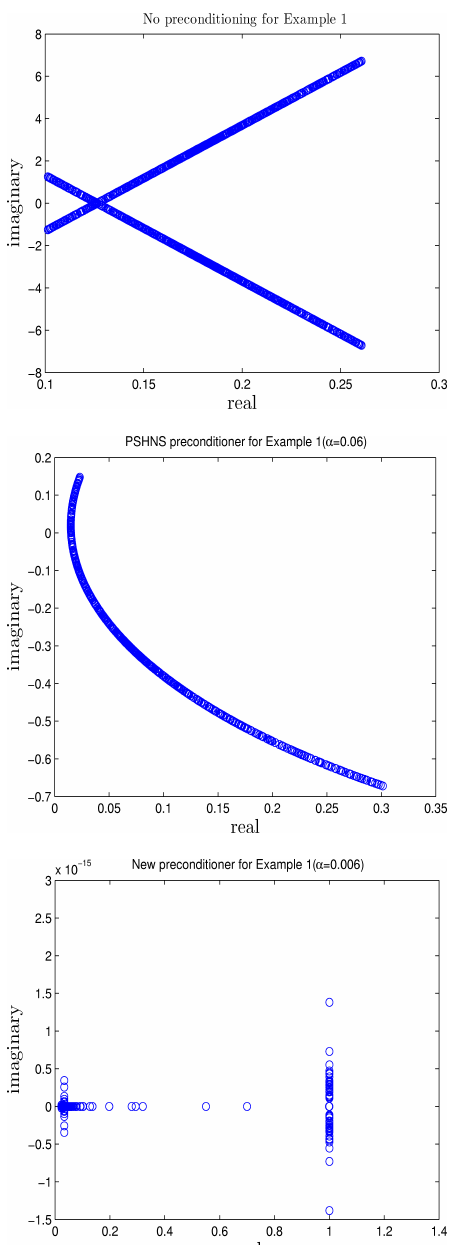
A , P − 1 A and P − 1 A for 2 HSS PSHNS